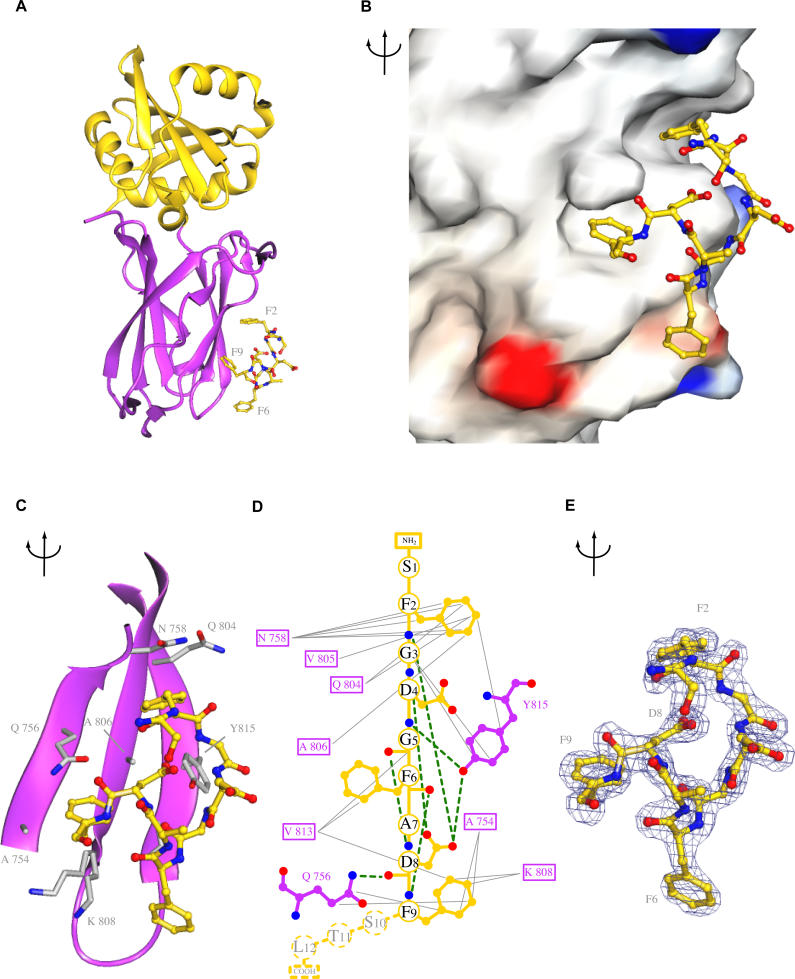
Eps15 Peptide Binds in a Tight Turn to the Side Site of the β2-Appendage(A) Ribbon diagram showing peptide in yellow bound to side site of the β-appendage.(B and C) The two principle Phe residues of the peptide bind in a groove. A single turn of a helix can also be seen for this peptide.(D) Peptide displayed as a linear chain showing hydrogen-bonding potential (green lines) and hydrophobic interactions (grey lines). A cluster of hydrogen-bonds in the peptide is consistent with the α-helical conformation in this region.(E) Density map for the peptide contoured at 1.24 σ.